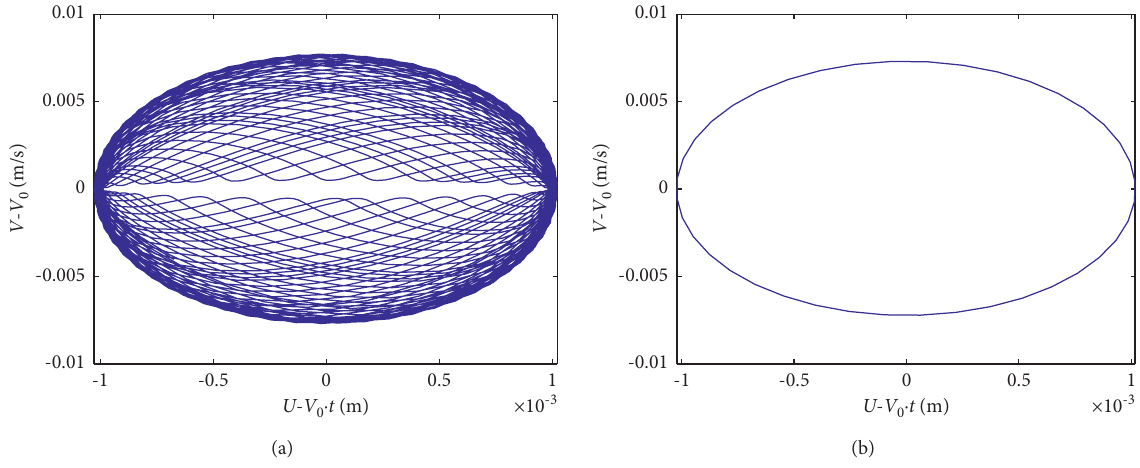
Figure 9: Bit pressure with different nominal bit pressure and turntable angular velocity k � and (c) W 0